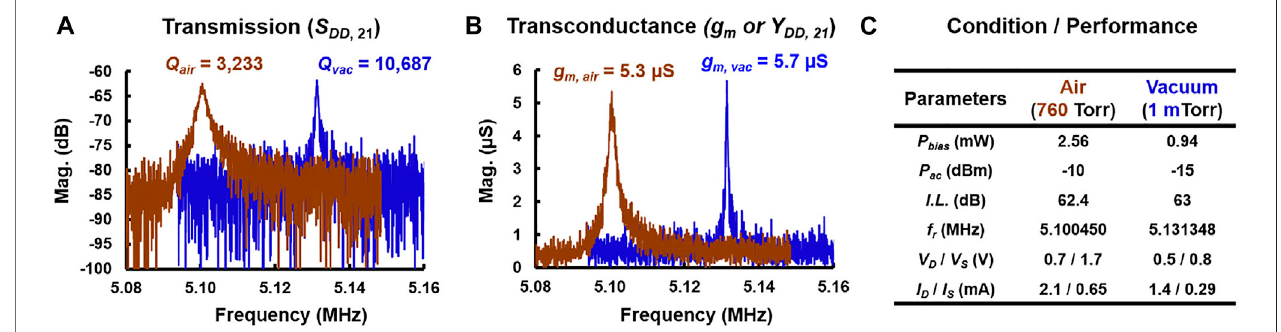
FIGURE 8 | Measured frequency response of II-bar in vacuum (blue) and air (brown). (A) S-parameter transmission magnitude plot with Q of 10,687 and 3,233 in vacuumand air, respectively. (B) ConvertedY-parameter magnitude,thatis, transconductance ( g m ) ofabout 5 µS invacuum and air. (C) Bias conditions and measured parameters are summarized in the table.